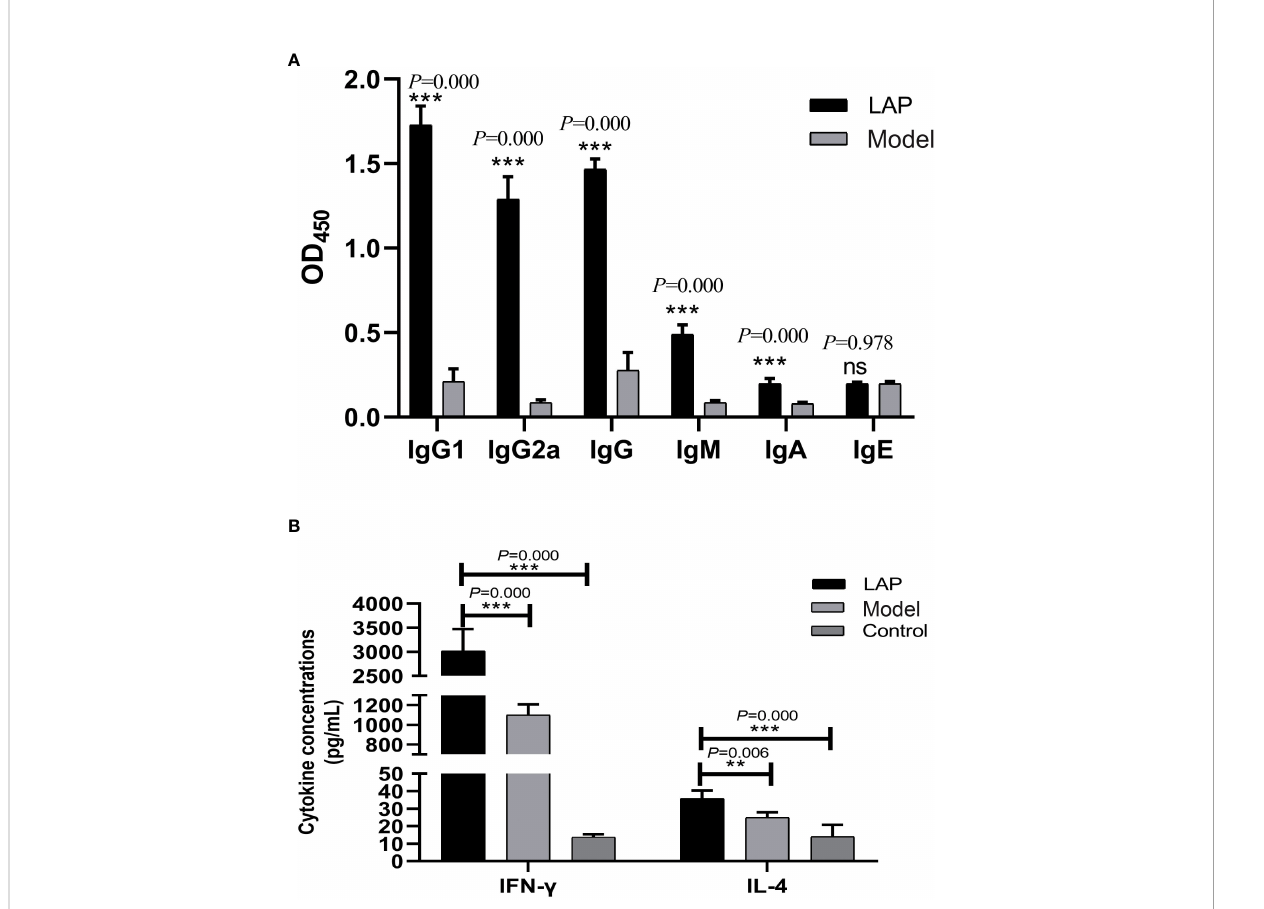
FIGURE 6 Immunological characteristics determined by ELISA. (A) The levels of antibodies. (B) Serum cytokine concentrations. **p<0.01, ***p<0.001, ns, no statistical signi fi